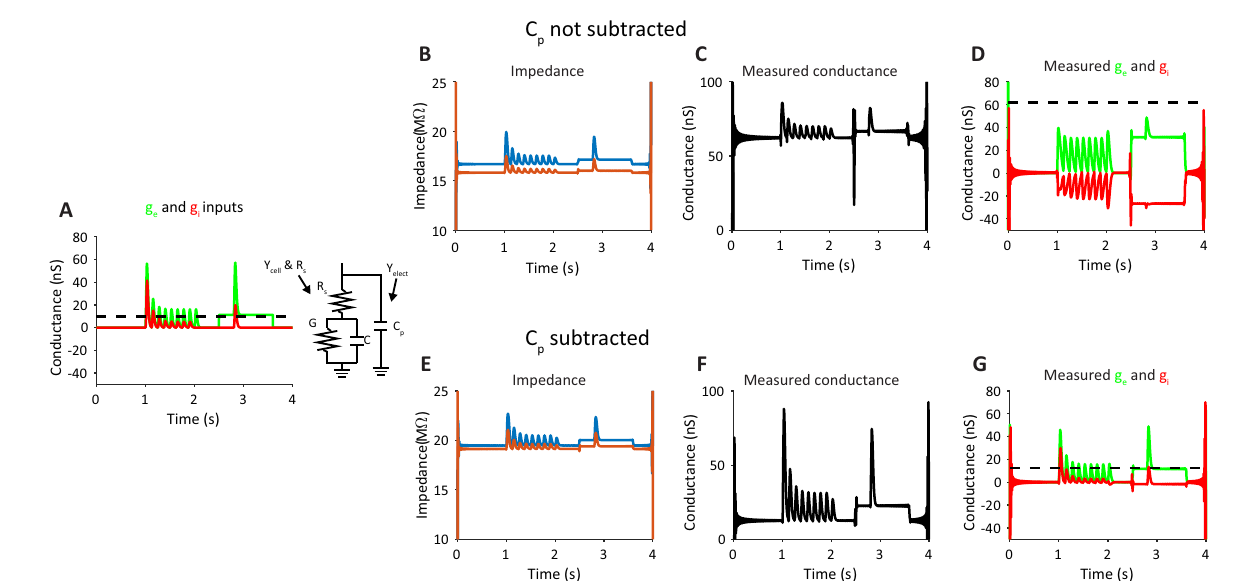
Fig 8. Computational approach for compensation of parasitic capacitance for measurement of excitation and inhibition in an in-silico model. A. The ‘real’ inputs in the in-silico experiment and the circuit representing the recording configuration. Note for C p , the parasitic capacitance of the electrode (R s ). B-D. Measurement of the impedance, followed by calculation of the conductance and E and I inputs using the approach described in Figs 3 and 4. E-G. Similar measurements when recalculating the impedance at each frequency using Eqs (13) to (18) to subtract the effect of pipette